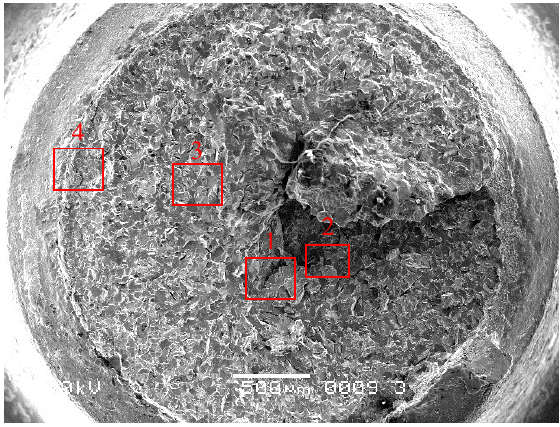
Figure 3. Low magnification of fracture surface of #1 screws (500 μ m).